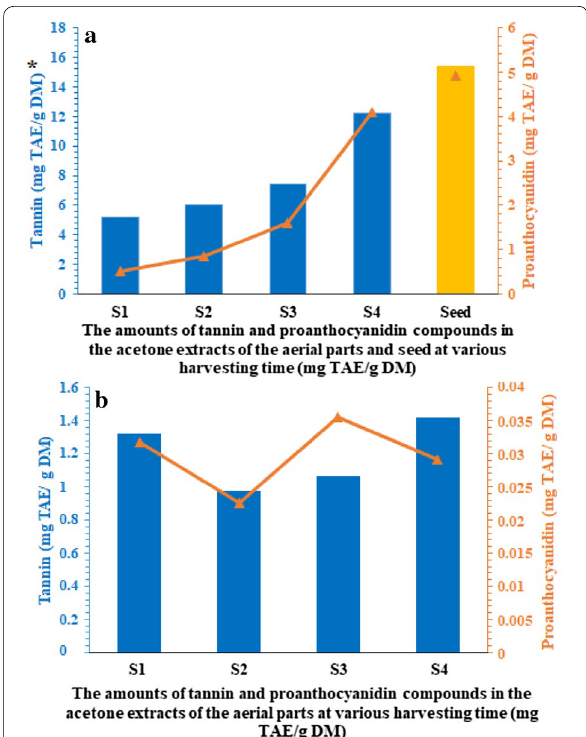
Fig. 5 The amounts of tannin (blue columns) and proanthocyanidin (yellow curves) and seed (yellow column) compounds in the tissues acetone extracts of the C. heratensis (mg TAE/g DM).*Tannin/ proanthocyanidin